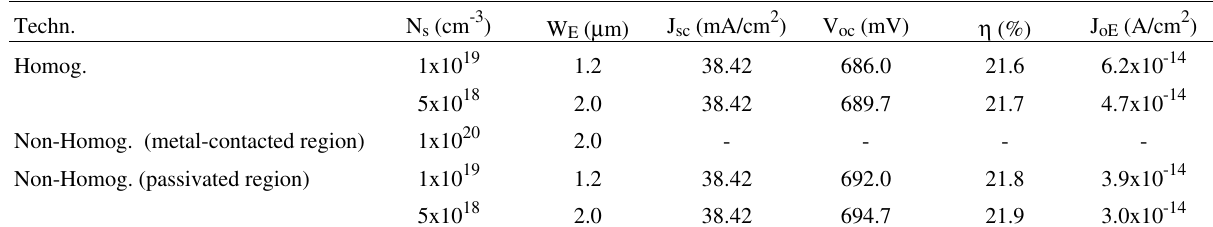
Table 2. Comparison between the optimum output electrical parameters for homogeneous and non-homogeneous emitter solar cells. Techn. N s (cm -3 ) W E ( µ m) J sc (mA/cm 2 ) V oc (mV) η (%) J oE (A/cm 2 ) Homog. 1x10 19